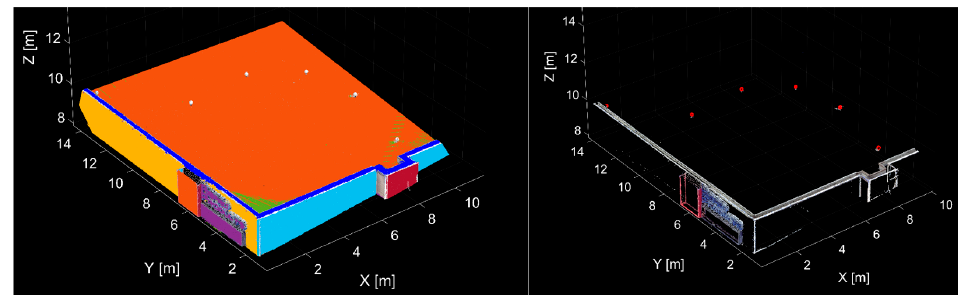
Figure 6. The segmented planes ( left ) and spheres ( right ).